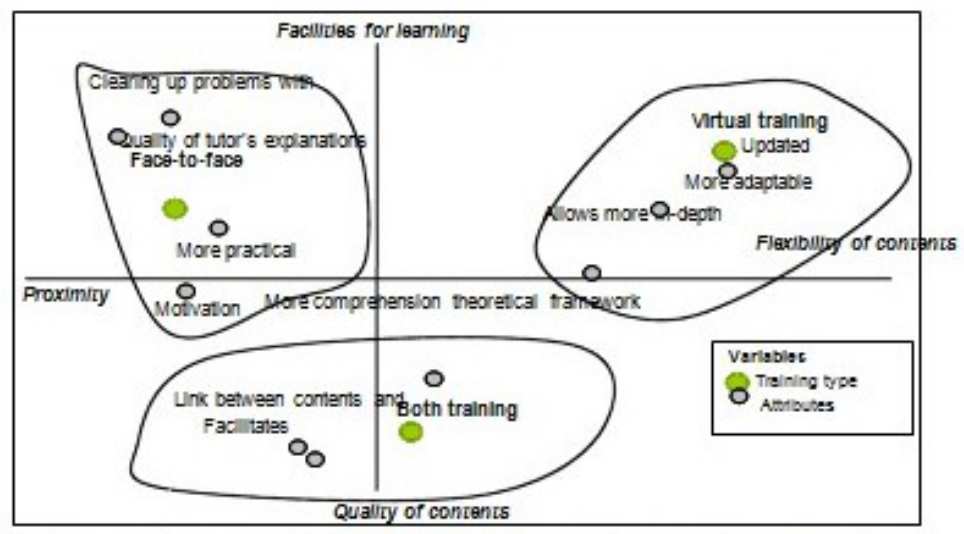
Figure 1. Perceptual map of attributes associated with virtual training, face-to-face training, and both methods, excluding the attribute flexible timetable